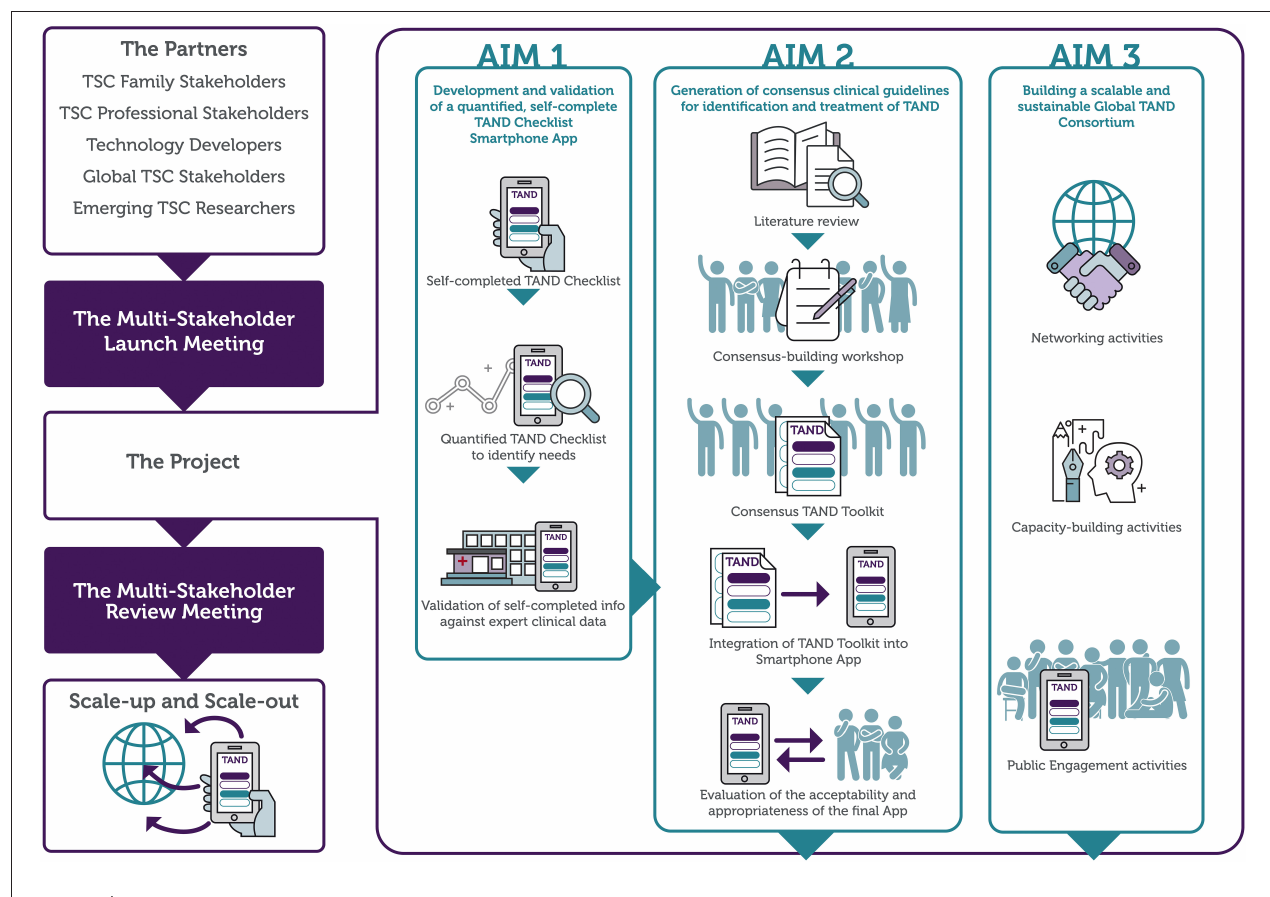
FIGURE 1 | An overview of the TANDem